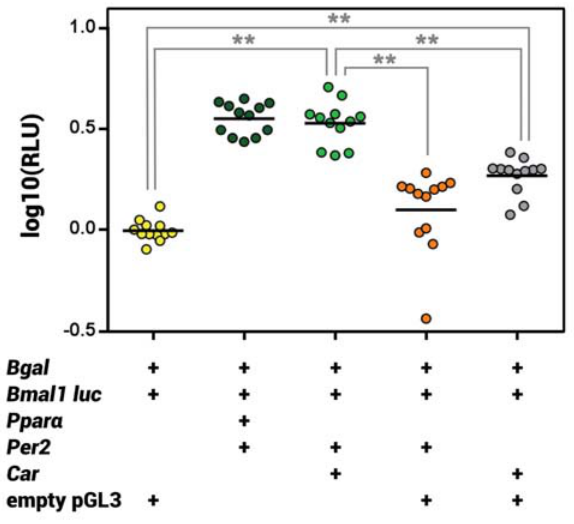
Figure 1. Co-transfection of Hepa 1–6 cells with CAR and PER2 overexpression plasmids induces promoter activity of Bmal1 luc reporter. This induction is similar to the one observed when performing co-transfections with Ppar α and Per2 (P < 0.0001) and different to the one observed when performing trans- fections with Car only (P < 0.0001). The log10 relative luciferase units of individual wells for the specific transfection mix are shown. ** - P <